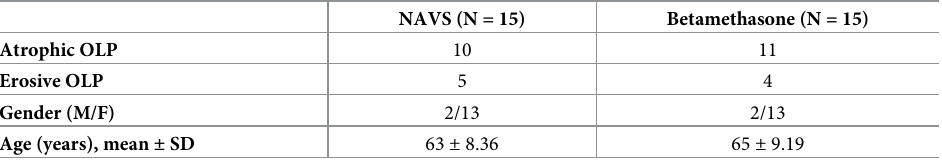
Table 2. Demographics and clinical features of the OLP patients (NAVS—“Non-aromatic very rich in steranes